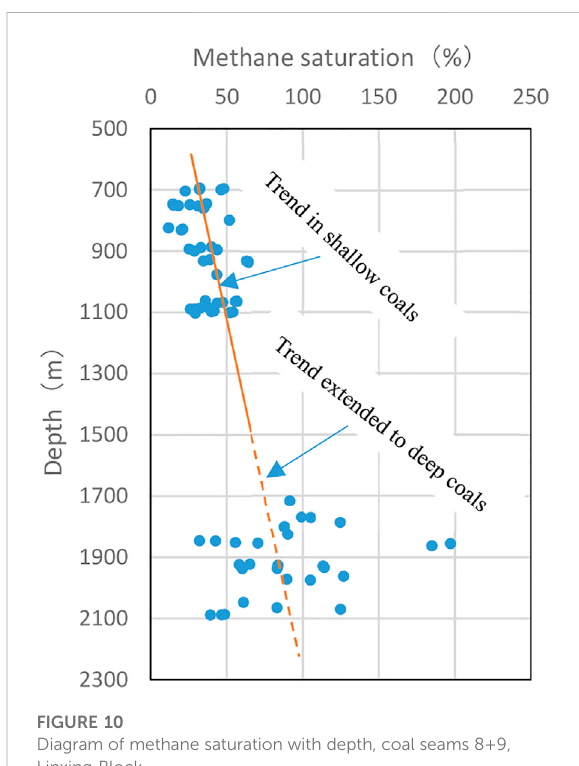
FIGURE 10 Diagram of methane saturation with depth, coal seams 8+9, Linxing